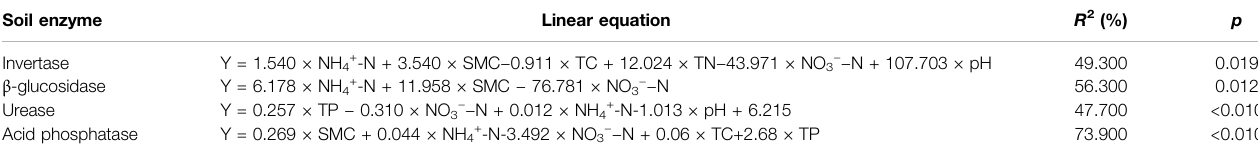
TABLE 5 | Stepwise linear regression equation of soil enzyme activities and soil physicochemical properties. Soil enzyme Linear equation R 2 (%) p